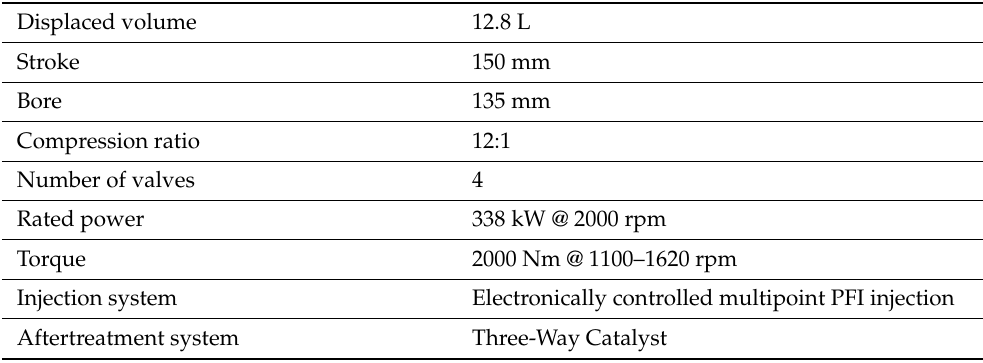
Table 1. Main characteristics of the HD CNG 6-cyl experimental